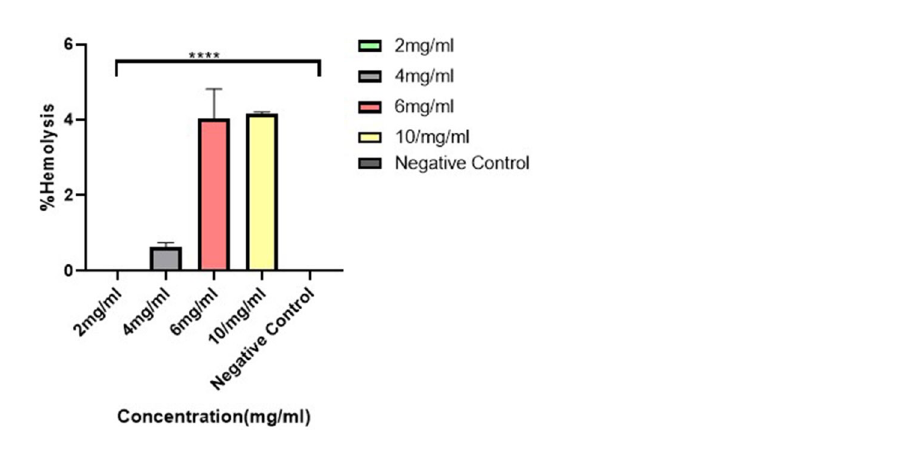
Figure 9. Hemolysis plot. The plot shows the percentage of hemolysis after the treatment of samples with different concentrations of PDA/HA/Gd 3+ and PBS (negative control). Data are demonstrated as mean ± SD (n = 3). The significant difference levels are shown with asterisks compared to the negative control (**** means a p -value less than 0.0001).